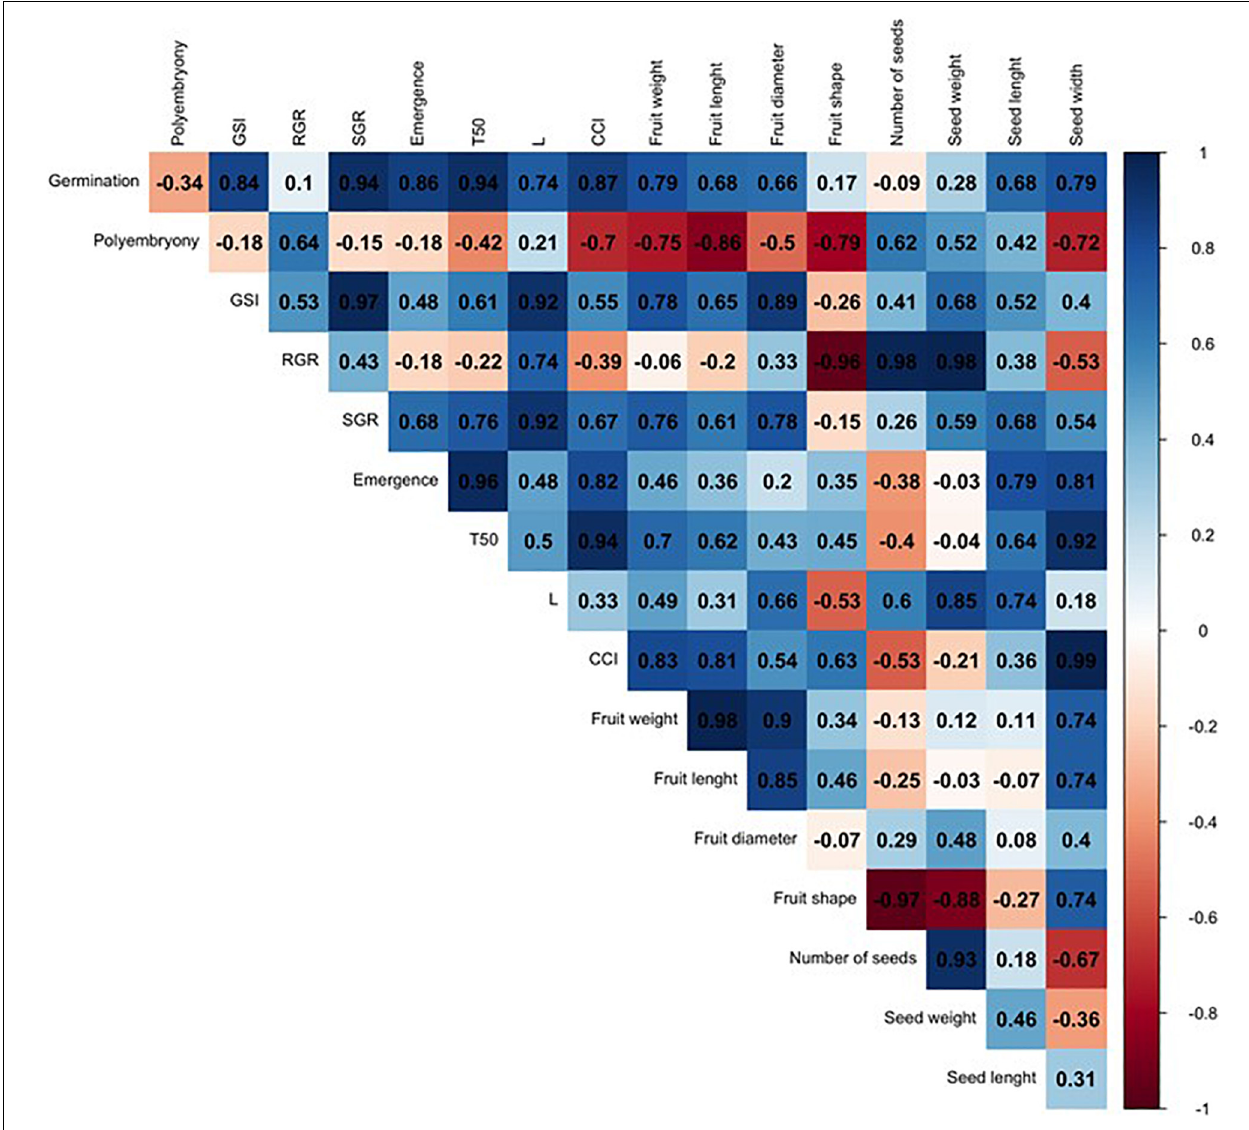
FIGURE 6 | Correlation analysis among the variables studied for US-802 rootstock. The numbers display the Pearson’s correlation coefficient (r). Blue cells indicate positive correlations among the variables (1) and the red cells indicate negative correlations (–1). The color density and numbers reflect the scale of correlation. Variables: germination; polyembryony; GSI: germination speed index; RGR: root growth rate; SGR: shoot growth rate; emergence; T50: days to reach 50% of the total emergence; L : lightness value; CCI: citrus color index; fruit weight; fruit length; fruit diameter; fruit shape; number of seeds per fruit, seed weight; seed length; and seed